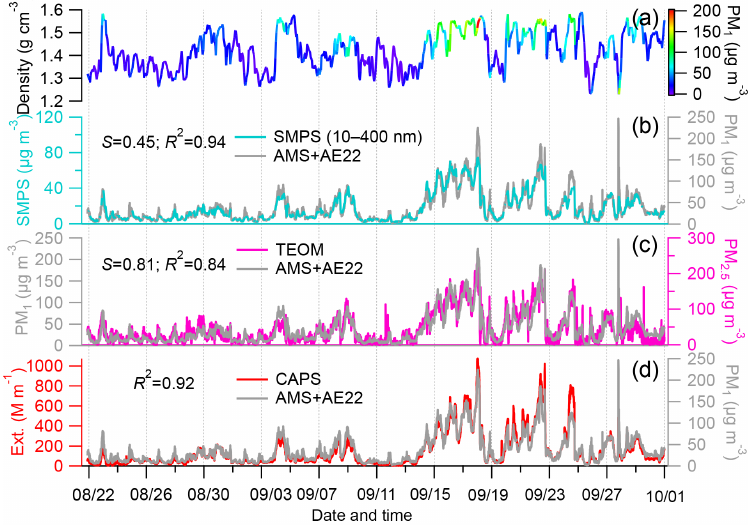
Figure 1. (a) Time series of particle density and intercomparisons between PM 1 (the combination of NR-PM 1 and BC) and (b) mass concentrations derived from SMPS measurements, (c) PM 2 . 5 and (d) the light extinction coefficient of PM 2 . 5 . The correlation coefficients ( R 2 ) and regression slopes ( S ) are also given in (b–d)